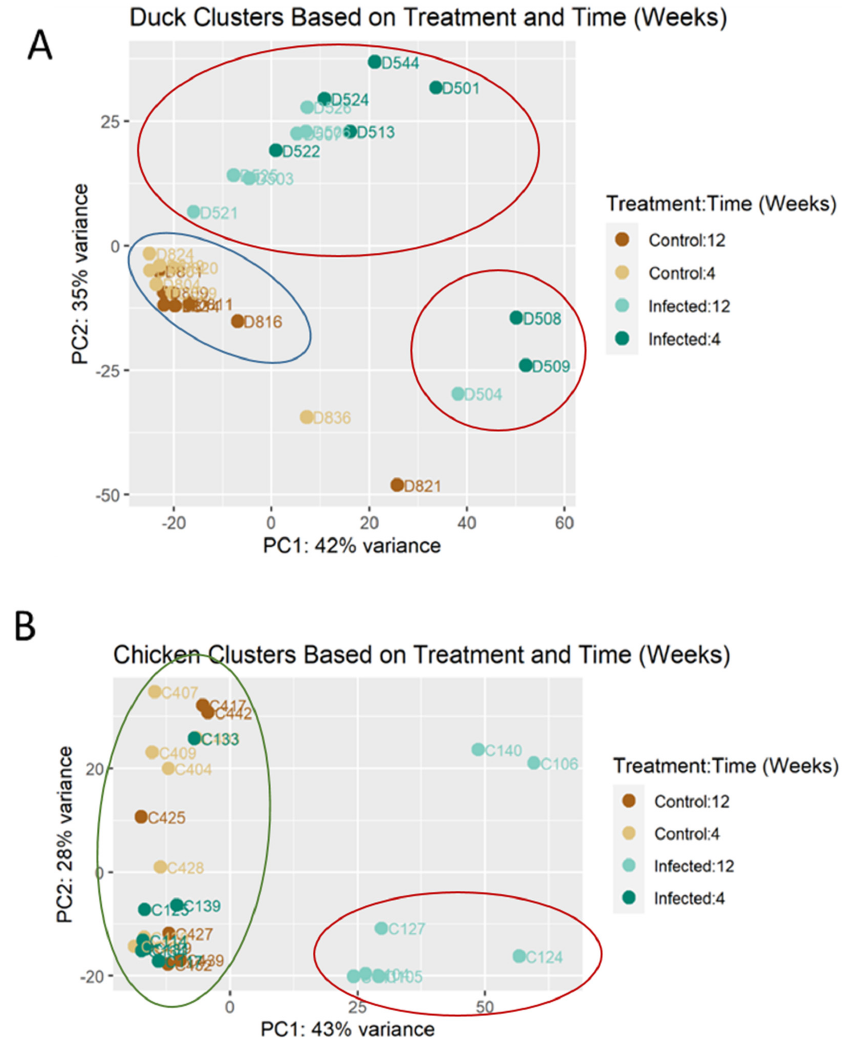
Figure 1. Principal component analysis (PCA) plot of Muscovy duck ( A ) and chicken ( B ) cohorts infected with ABBV − 1. Light brown and dark brown represent control birds from 4 and 12 wpi, respectively. Light blue and dark bluerepresent infected birds from 4 and 12 wpi, respectively. The alphanumeric code adjacent to each data point represents a single bird identifier. For each species, there were 7 birds per treatment per time point. Red circle shows clustering of infected animals and blue circle shows clustering of control animals. Green circle shows mixture of infected and control animals.